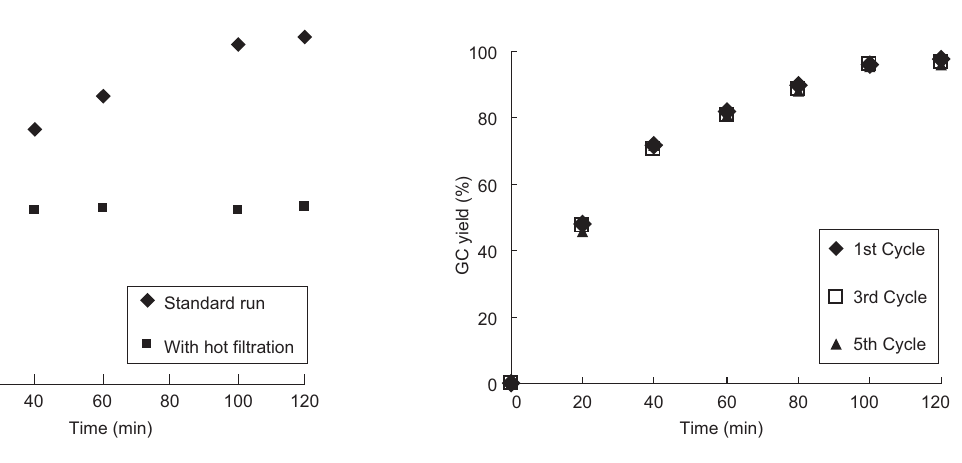
Figure 2 The Sonogashira reaction of iodobenzene and phenyl- acetylene at different cycles.